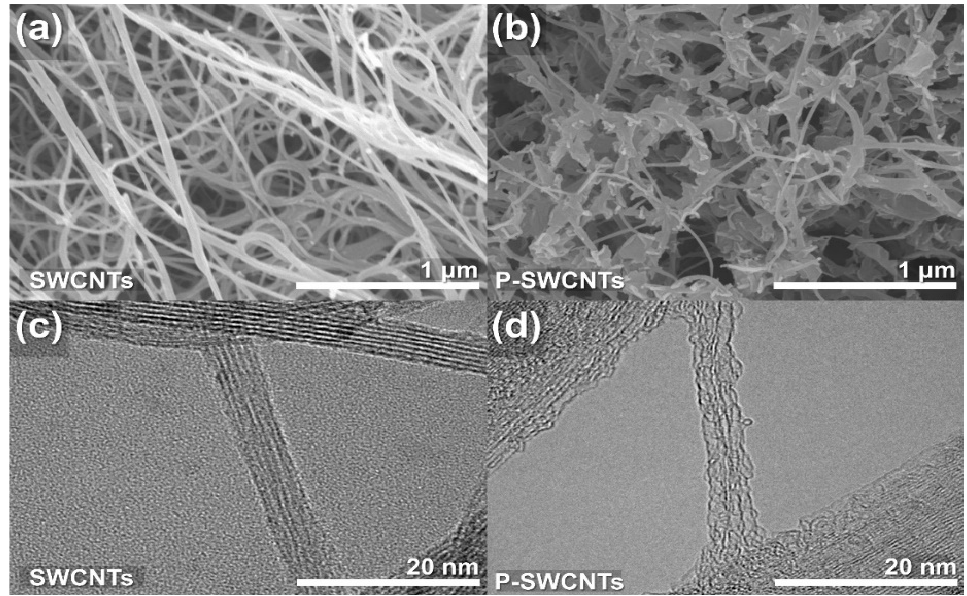
Figure 3. Surface morphology of SWCNTs and P-SWCNTs: ( a , b ) HR-SEM images and ( c , d ) FE-TEM.